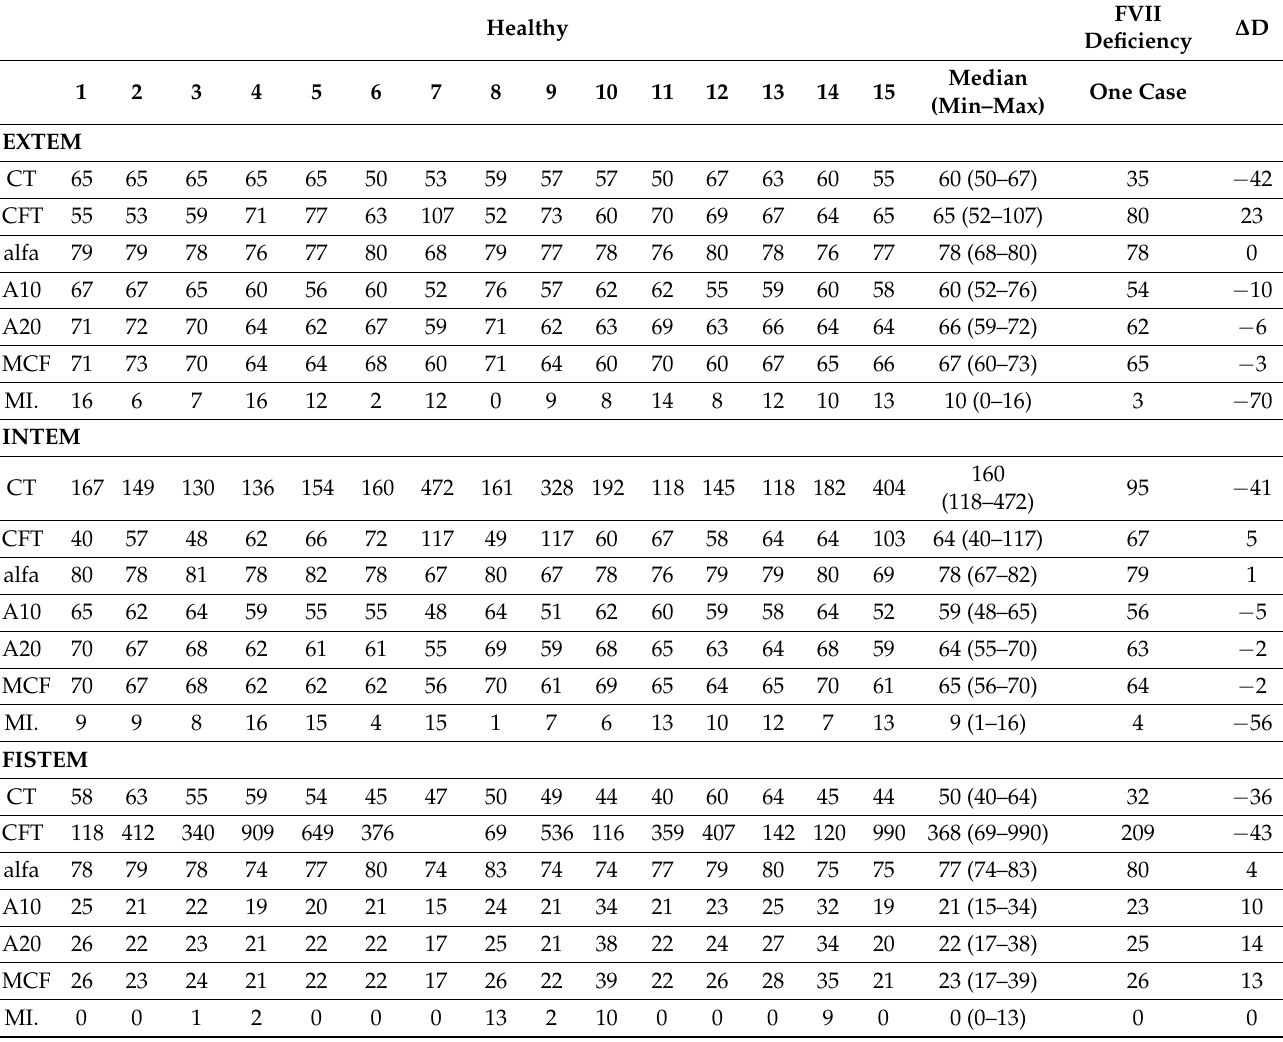
Table 2. Thromboelastometry